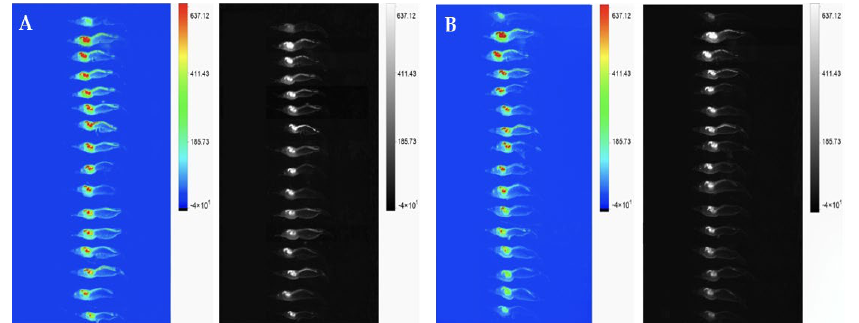
Figure 7. Clove oil biodistribution after exposure. RGB spectrum and gray scale of STD-CO ( A ) and CO-NLCs ( B ) in the whiteleg shrimp at 2 to 30 min after recovery. Images revealed the residual and excretion of CO using multicolor fluorescence distribution. High intensity CO appears as a red color, while low intensity CO appears as a green color.